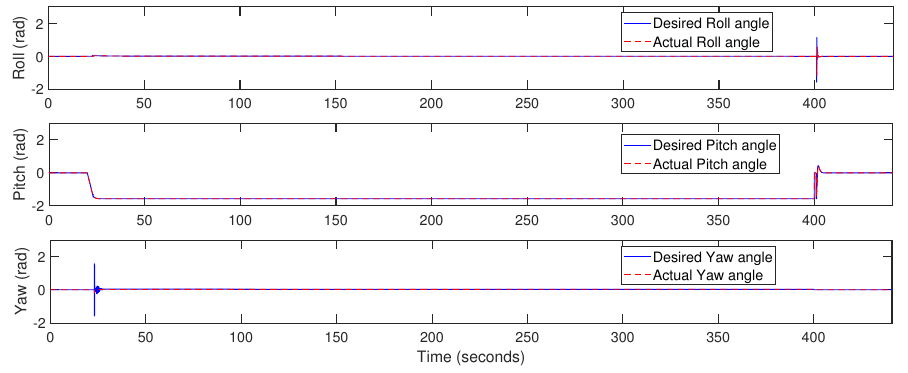
Figure 8. Attitude tracking by backstepping controller.